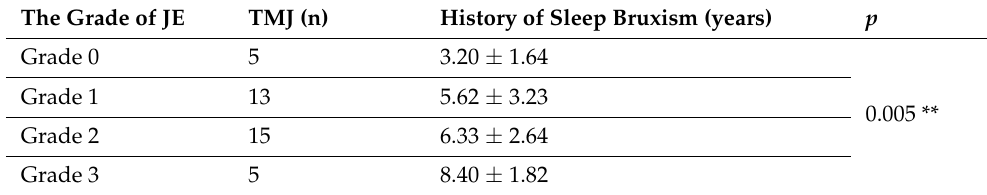
Table 4. The association between the grade of joint effusion and the history of sleep bruxism.